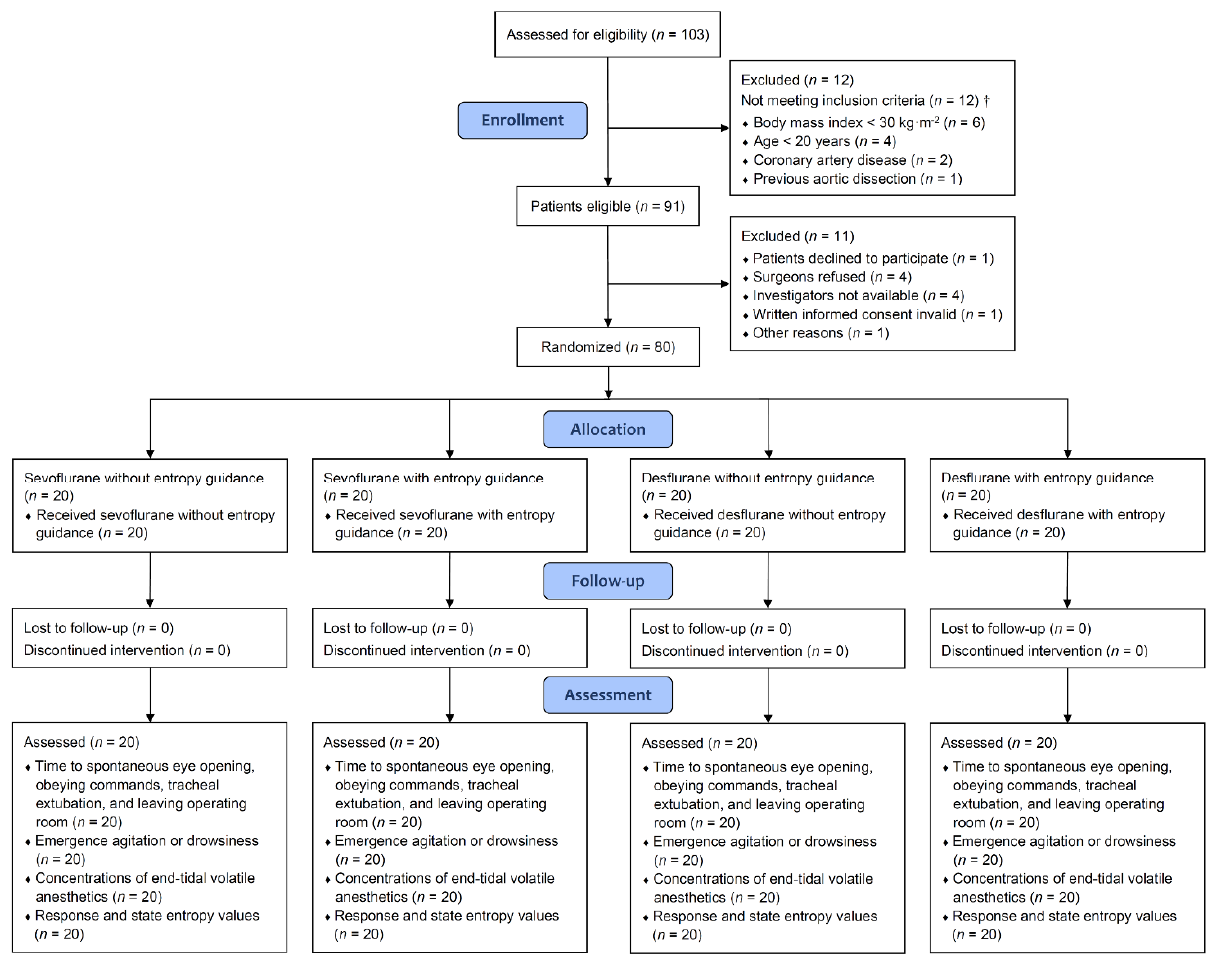
Figure 1. Consolidated Standards of Reporting Trials flow diagram. † Not mutually exclusive, since patients could have more than one exclusion criterion.